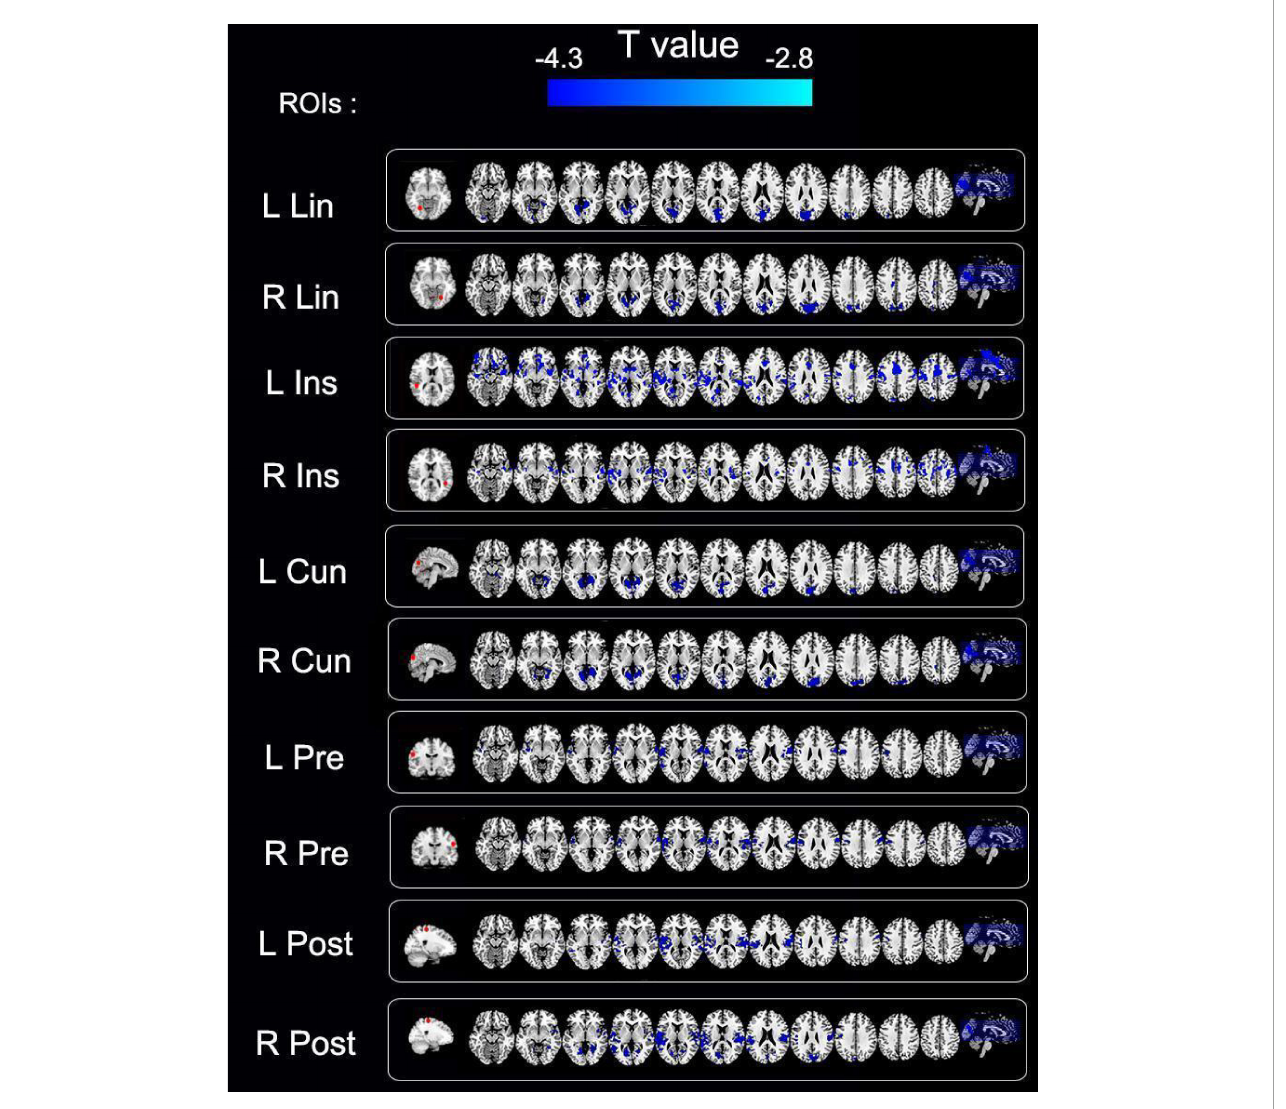
FIGURE4 Group differences in functional connectivity of regions of interest (ROIs) between primary angle-closure glaucoma (PACG) and healthy control (HC). Significant functional connectivity values were observed in the default, salience, visual, and sensorimotor networks. ROIs, regions of interest; R, right; L, Left; Lin, lingual gyrus; Ins, insula; Cun, cuneus; Pre, pre-central gyrus; Post, post-central gyrus; cluster-level P < 0.005; cluster > 26 voxels, AlphaSim